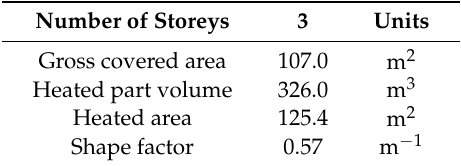
Table 7. Basic geometric data of the two-storey building with a flat roof.